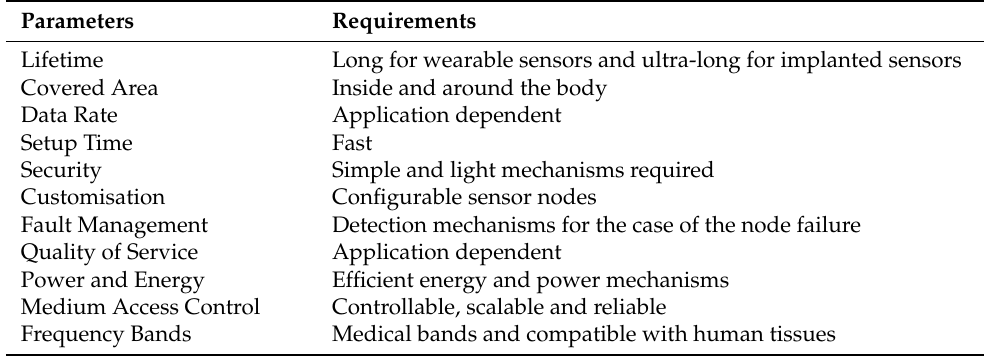
Table 2. Characteristics and requirement analysis of WBASNs